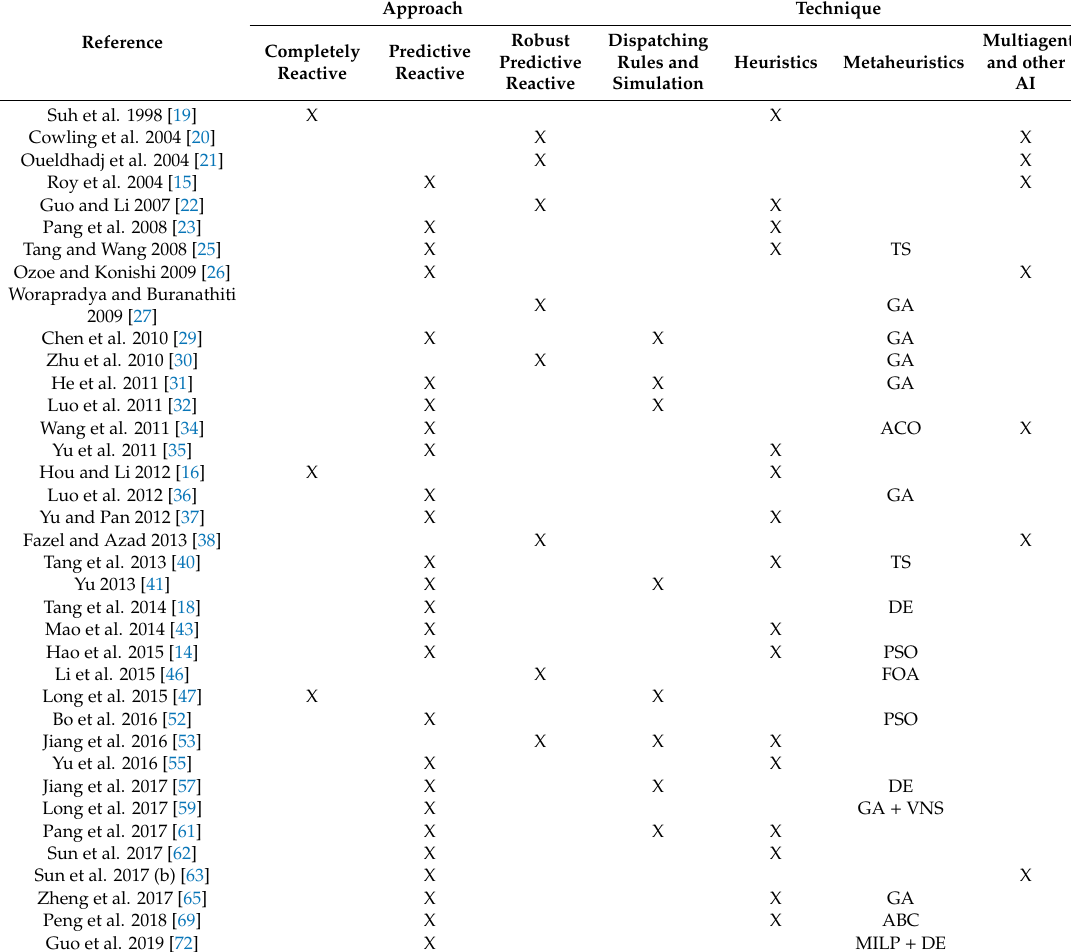
Table 2. Reactive scheduling models in steel